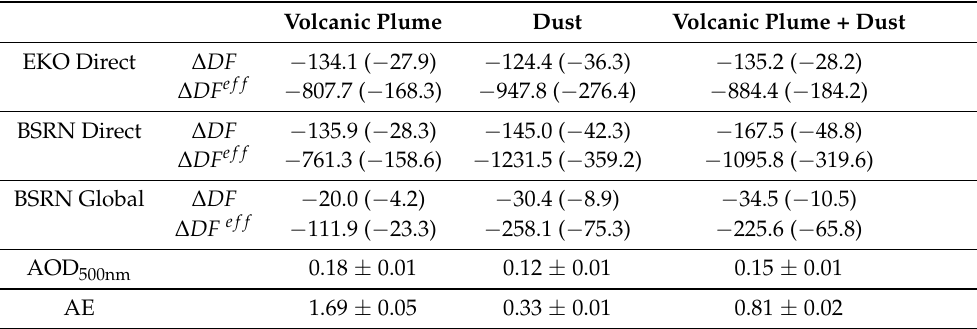
Table A1. Summary of averaged aerosol radiative forcing ( ∆ DF , Wm − 2 ) and aerosol radiative